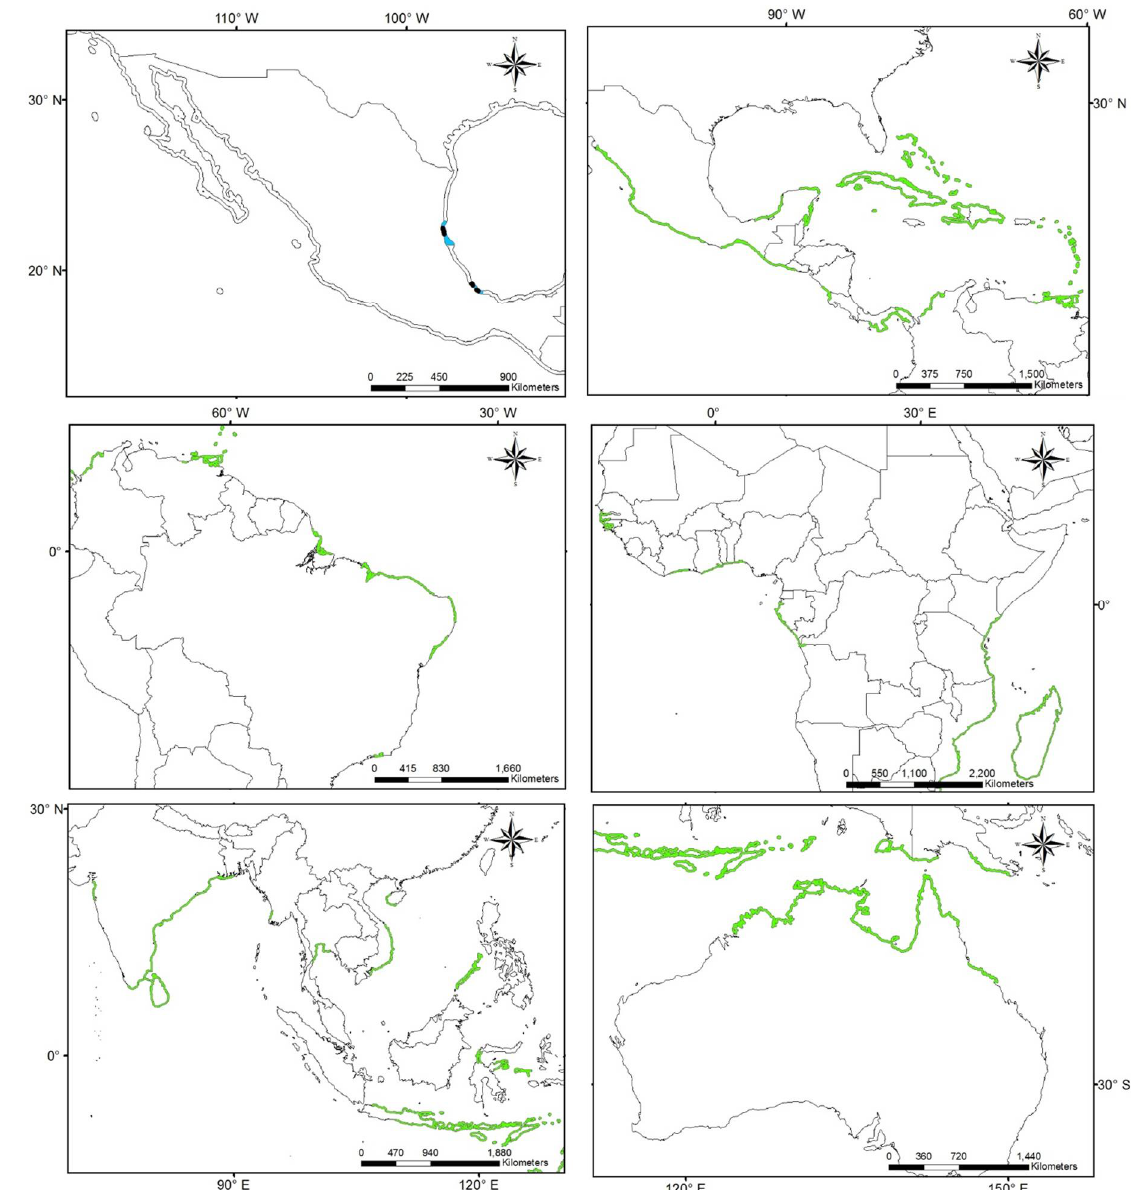
Figure A2. Training (blue) and projection (green) areas for the construction of the models corresponding to Tropical savanna climate with dry-winter characteristics (Aw). Black dots represent occurrence records.